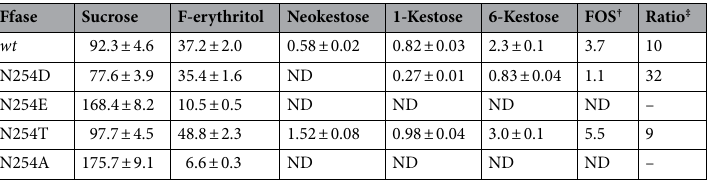
Table 1. Concentration (g l −1 ) of the sugar constituents present at maximum fructosyl-erythritol production in reaction mixtures based on sucrose and erythritol with the referred Ffase variants. † Concentration of FOS: neokestose, 1-kestose and 6-kestose. ‡ Ratio between fructosyl-erythritol (F-erythritol) and total FOS (weight ratio). ND: Not detected. Data represents the average of two independent measurements obtained after 3 h and 2 h of reaction for variants wt /N254E/A and N254D/T, respectively. Standard deviation values are indicated.